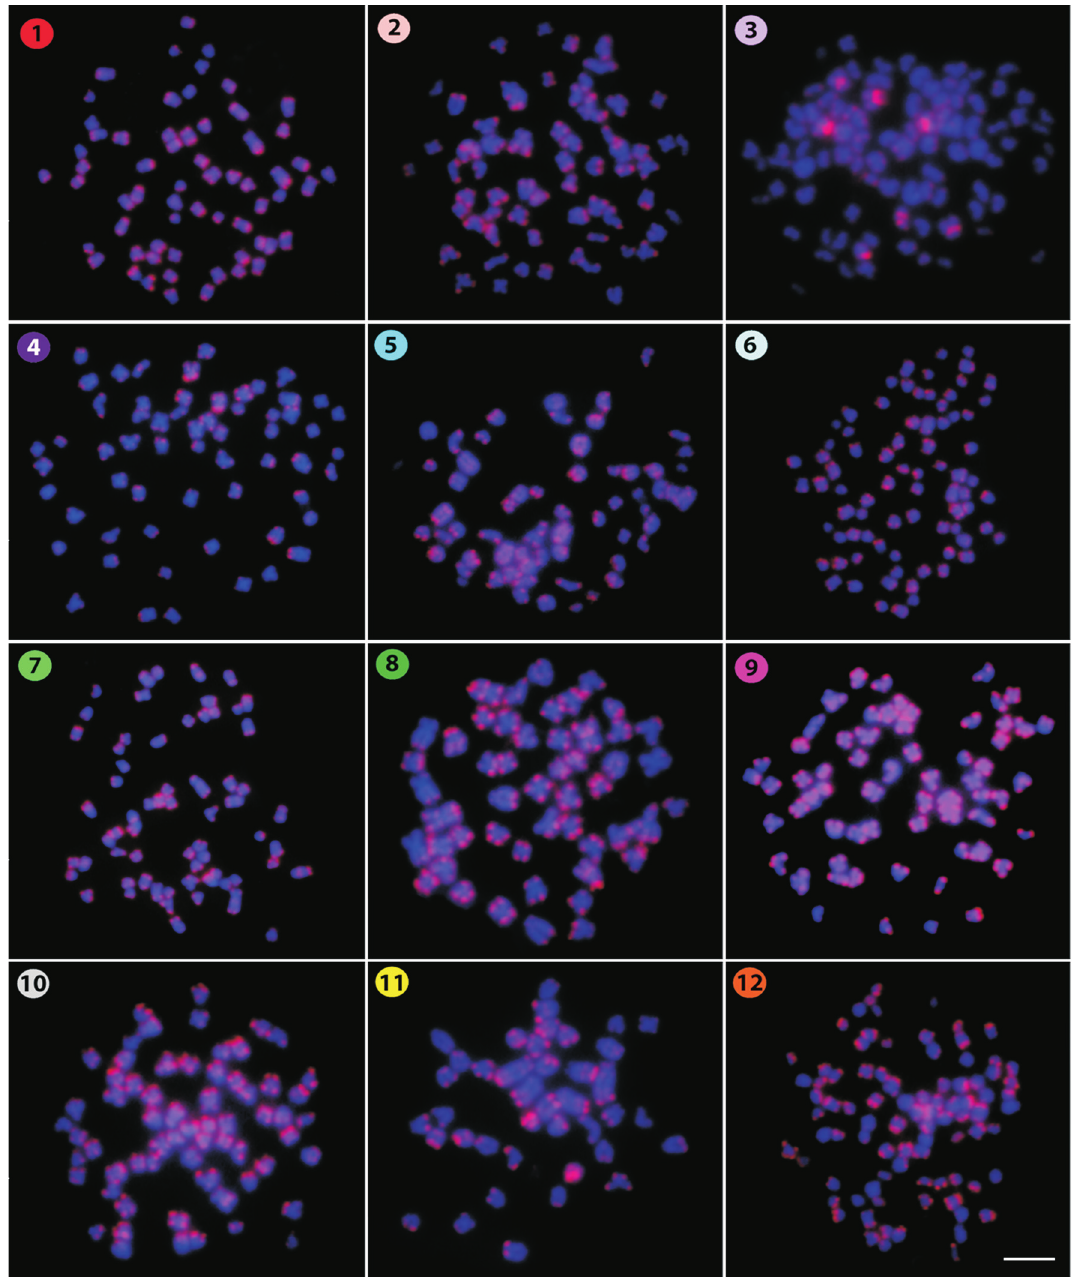
Figure 2 - Hybridization pattern of the (CA) 15 microsatellite probe (in red) on metaphase chromosomes of Belodontichthys truncates ( 1 ); Kryptopterus bicirrhis ( 2 ); Kryptopterus geminus ( 3 ); Kryptopterus limpok ( 4 ); Kryptopterus macrocephalus ( 5 ); Micronema chevevi ( 6 ); Ompok fumidus ( 7 ); Ompok siluroides ( 8 ); Phalacronotus apogon ( 9 ); Phalacronotus bleekeri ( 10 ); Silurichthys phaiosoma ( 11 ) and Wallago attu ( 12 ). Scale bar = 5 (cid:2)